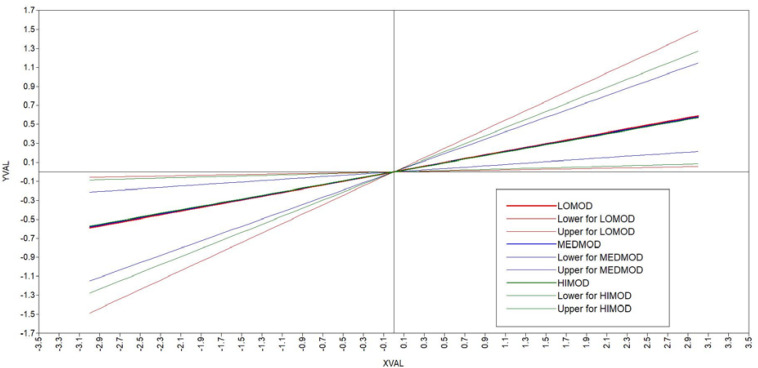
Conditional indirect effects represented graphically with 95% confidence interval.